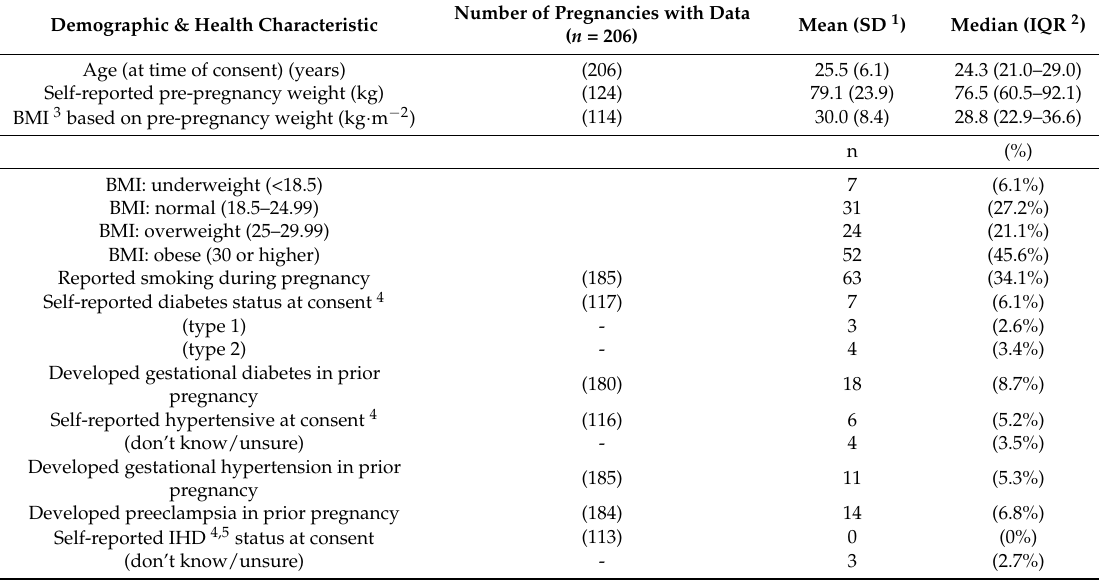
Table 1. Demographic and health characteristics of women at the time of their